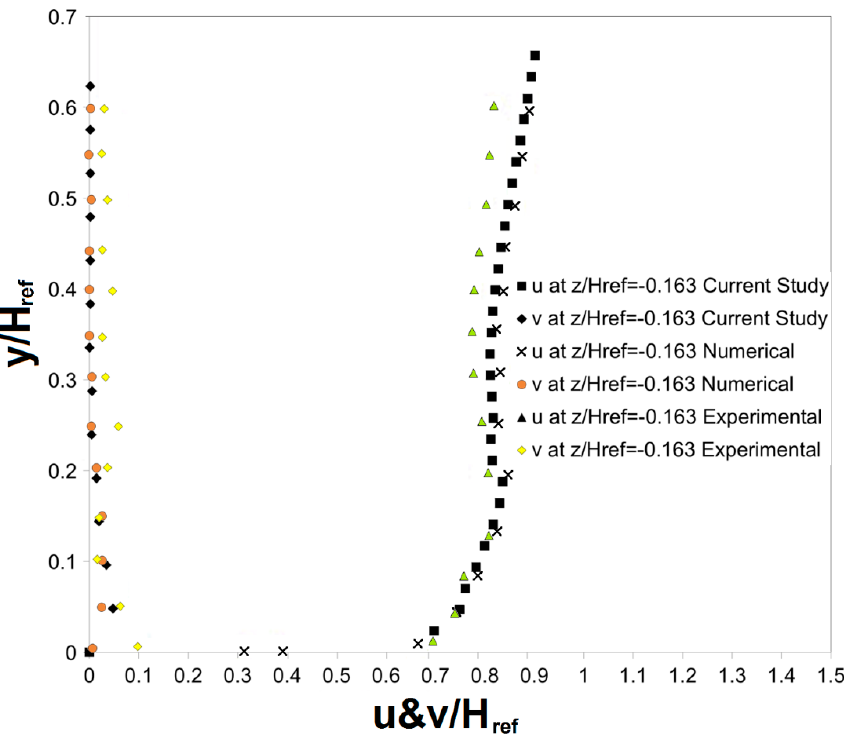
Figure 7. Comparison between numerical predictions and numerical/experimental data [37] for streamwise and cross-stream velocity results at z / H ref = − 0.163.